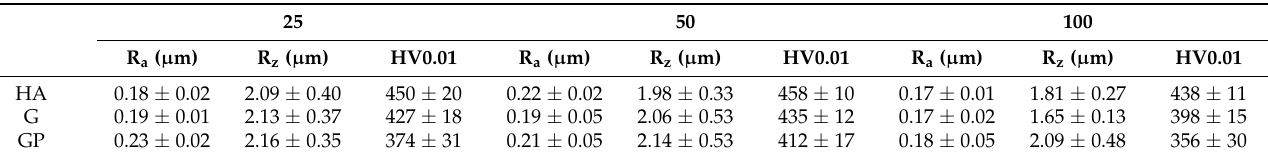
Figure 4. Representative DRIFT-FTIR spectrum of all pin surfaces before wear tests. Table 2. Mean values ± standard deviations of the roughness parameters (R a and R z ) and Vickers microhardness (HV0.01) for all anodizing treatments (HA, G, and GP) and thicknesses of AAO layers (25, 50, and 100 µ